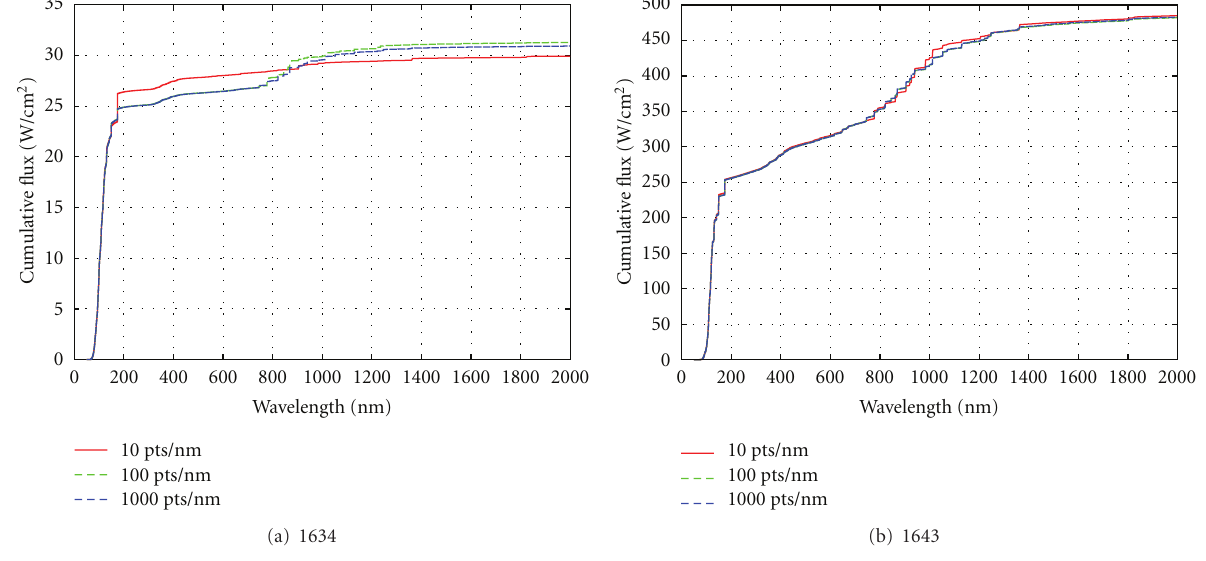
Figure 6: Spectral resolution